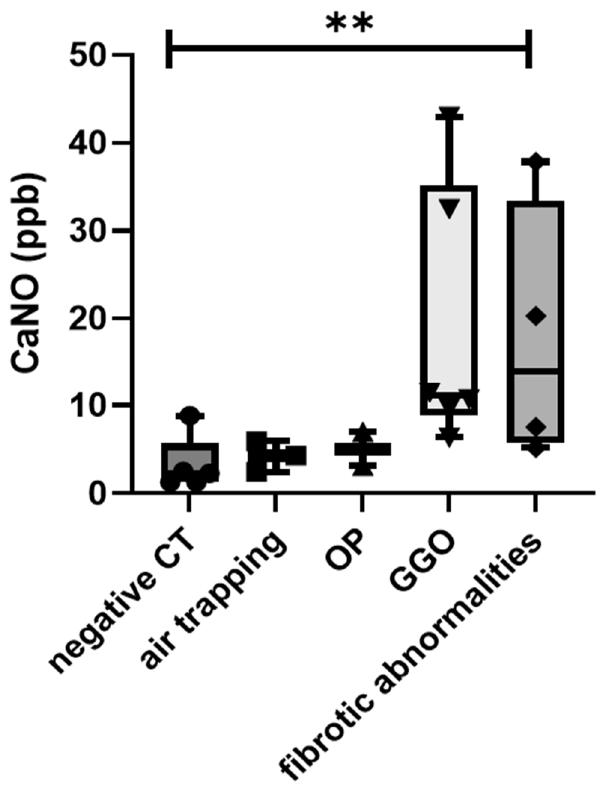
Figure 2. Comparison of CaNO values of post-COVID-19 patients among different CT phenotypes. **: p = 0.0291.